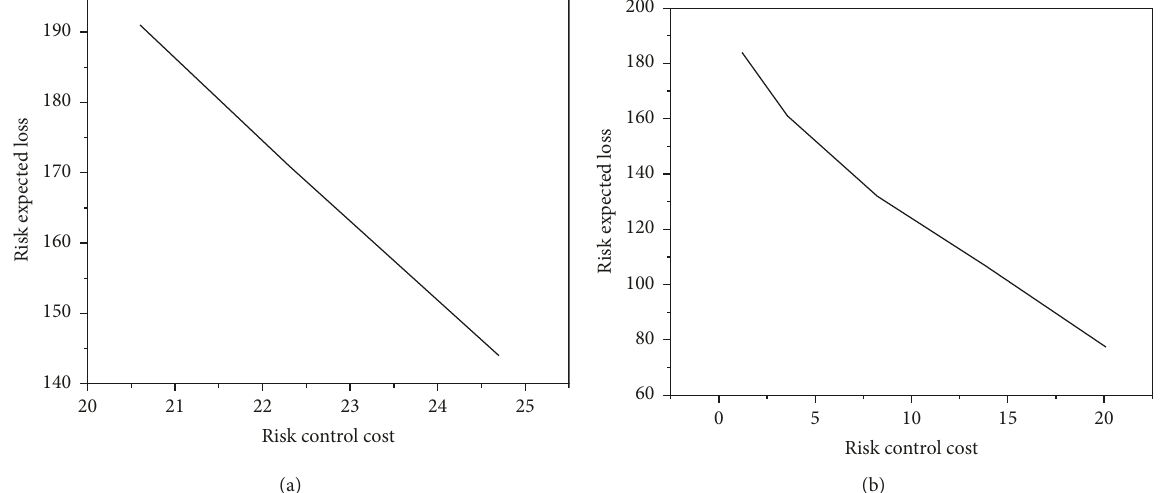
Figure 5: Comparison of noninferior solution sets under different constraints. (a) The cost constraint is 200,000 yuan. (b) The cost constraint is 240,000